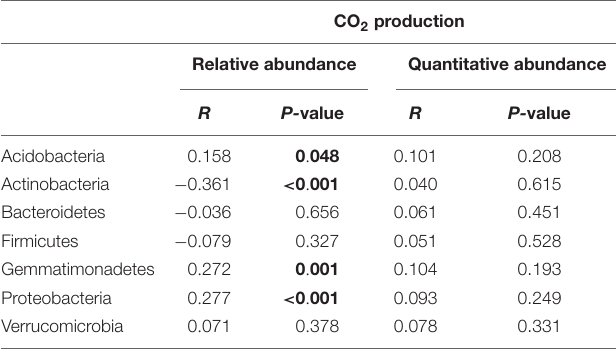
TABLE 1 | Correlation tests between relative and absolute abundances of the most abundant bacterial phyla associated with the rhizosphere of four wheat genotypes grown in Saskatchewan soils with a water stress history (NI) or with no history of water stress (IR) exposed to four levels of soil water content vs. CO 2